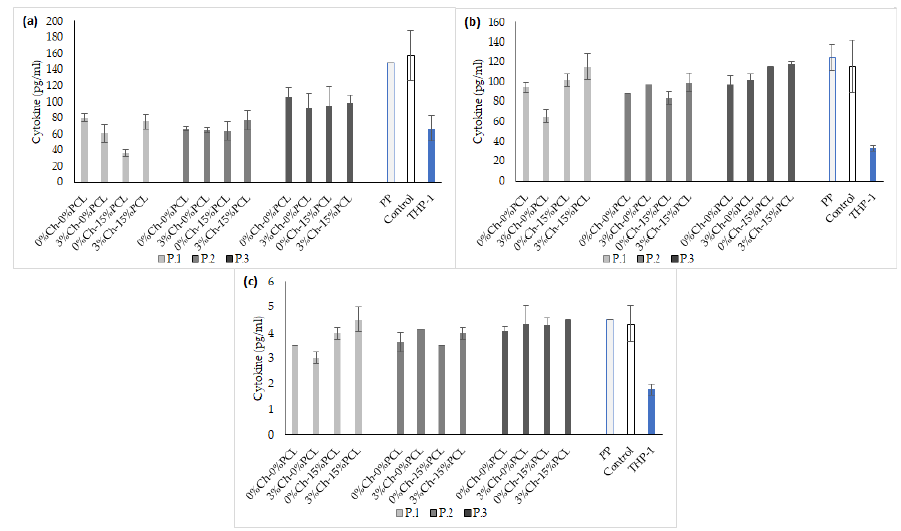
Figure 15. Anti-inflammatory cytokines without LPS stimulation. ( a ) IL-10; ( b ) IL-5; ( c ) IL-4. PP: polypropylene as a reference material; Control: culture medium without PUs; THP-1: monocyte cell line. The concentration of cytokines is expressed as the mean ± SD (n = 3).